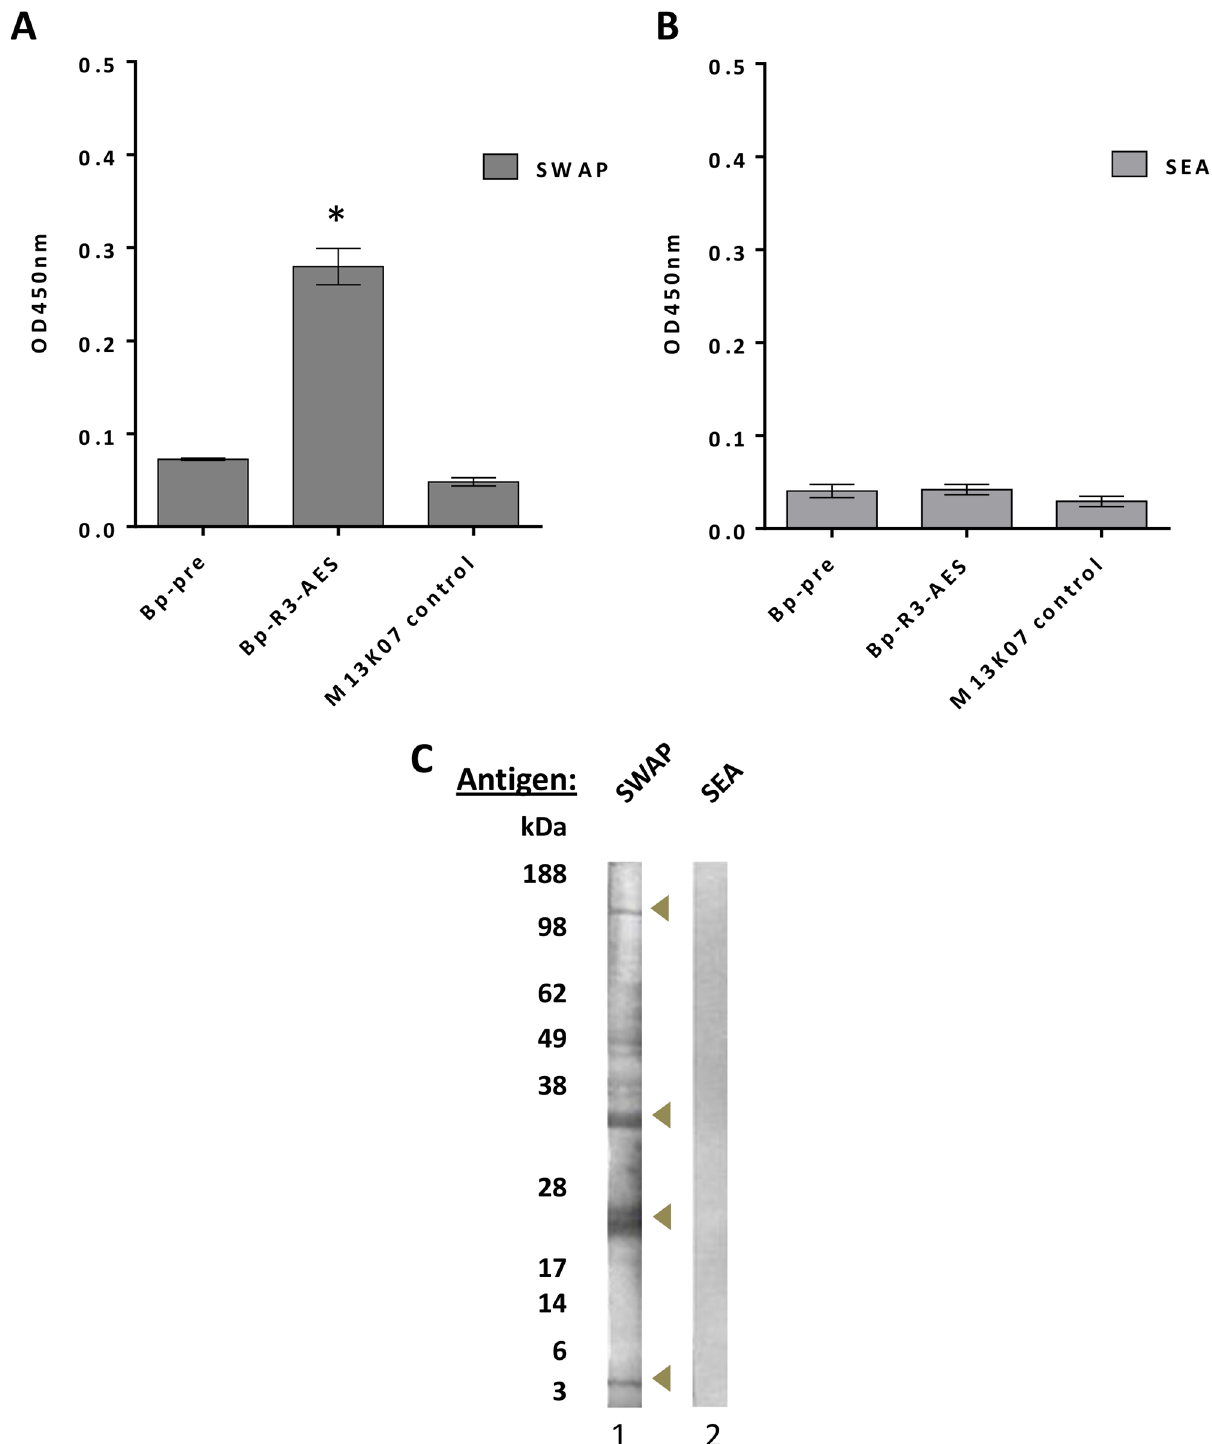
Fig 2. Binding of buffalo portal-round three selected-adult and ES pooled (Bp-R3-AES) single-chain Fv domain (scFv) phage library to Schistosoma japonicum protein extracts. Data represent mean ± S.E.M. of the O.D. 450nm for Bp-R3-AES phage binding to soluble whole adult preparations (SWAP) (A) and soluble egg antigens (SEA) (B). Statistical significance was determined by one-way ANOVA followed by Tukey ’ s post-hoc test, where * P < 0.05. Antigens from SWAP (Lane 1), and SEA (Lane 2) of S . japonicum were probed with Bp-R3-AES phage (C). Molecular weights in kilodaltons (kDa) are indicated on the left hand side. Regions of intense binding by Bp-R3 scFv phages to antigen preparations is indicated by